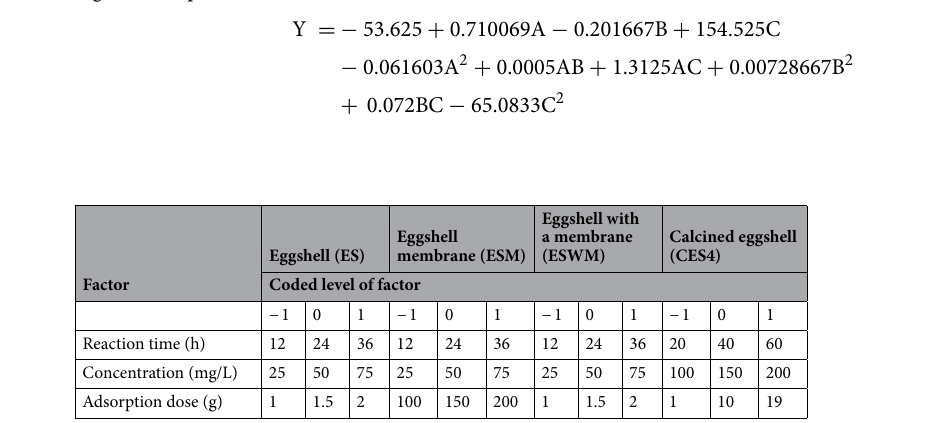
Table 1. Parameter range of the 3-level-3-factor Box–Behnken design (BBD) of adsorption rate from four different eggshells. A reaction temperature of 25 °C and pH 5.9 were used as fixing factors.